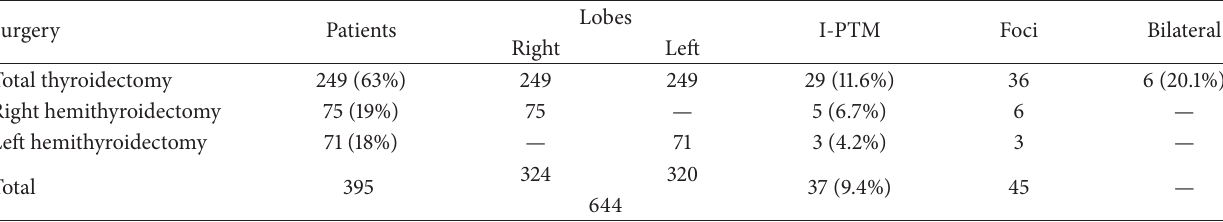
Table 3: Surgery of the thyroid gland and prevalence of I-PTM ∗ .